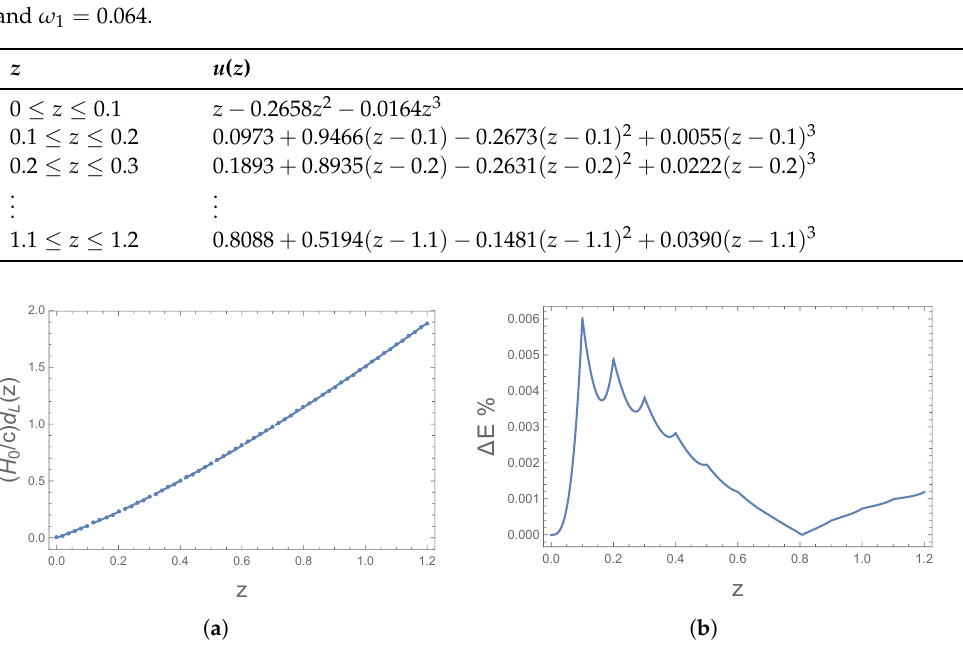
Figure 2. ( a ) The luminosity distance function ( H 0 / c ) d L ( z ) (solid curve) vs. the redshift z for the CPL model with Ω m = 0.311, ω 0 = − 0.937, and ω 1 = 0.064. The corresponding numerical solution obtained by integrating (12) is also shown as plotted points for discrete values of z . ( b ) The absolute relative percentage error of the luminosity distance ∆ E vs. the redshift z for the same redshift